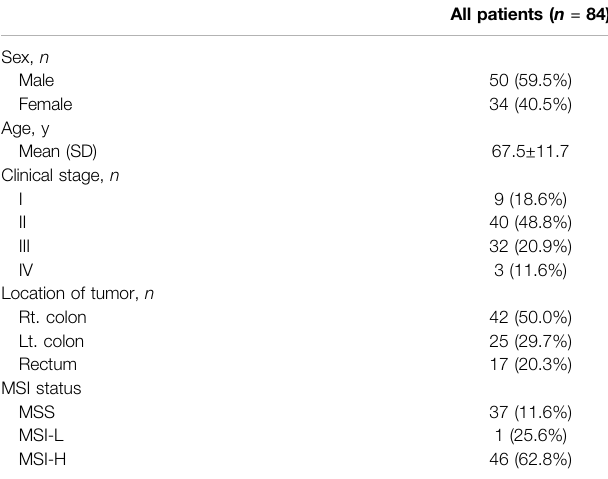
TABLE 1 | Basal clinicopathological characteristics of enrolled